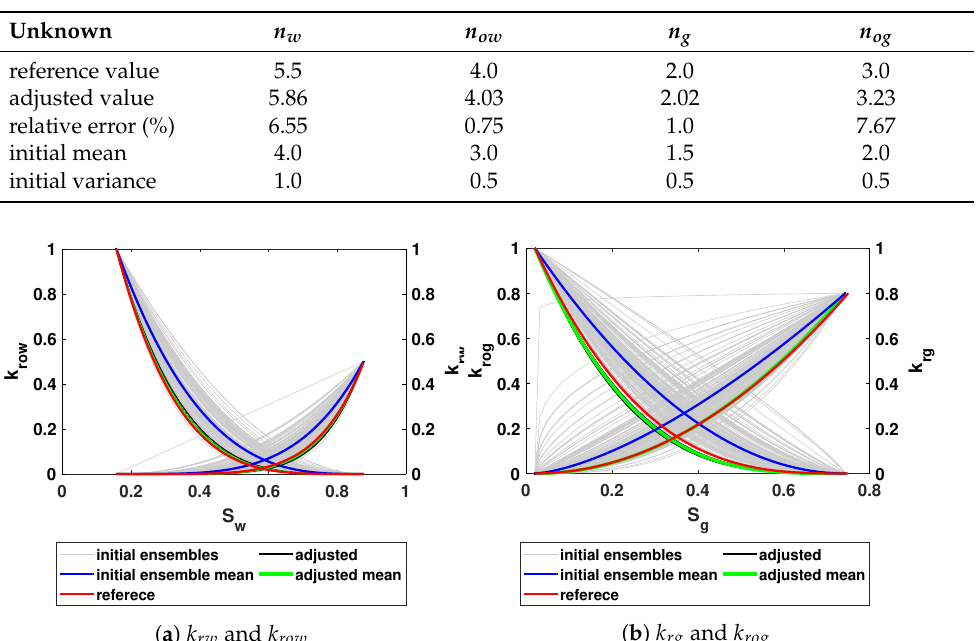
Table 2. This table shows the reference values, the adjusted values and the relative errors at the last assimilation step, the initial ensemble means and variances of the four parameters in Equation (13).